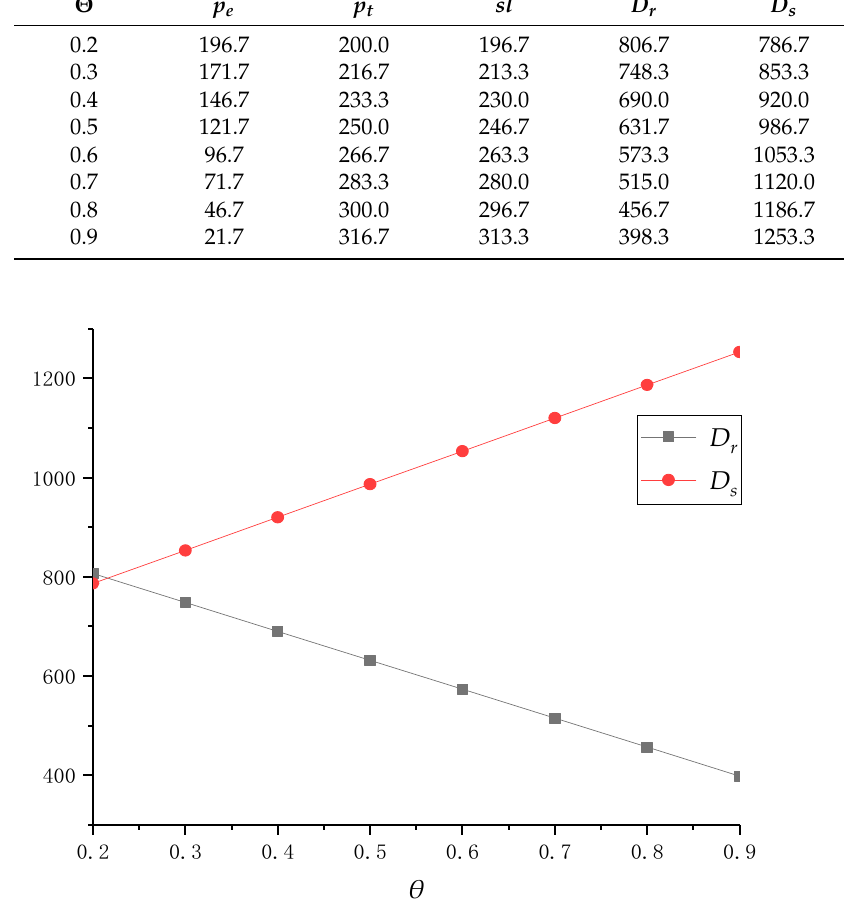
Figure 2. The collective quantity changes in dual channels with different Θ when μ = 4.